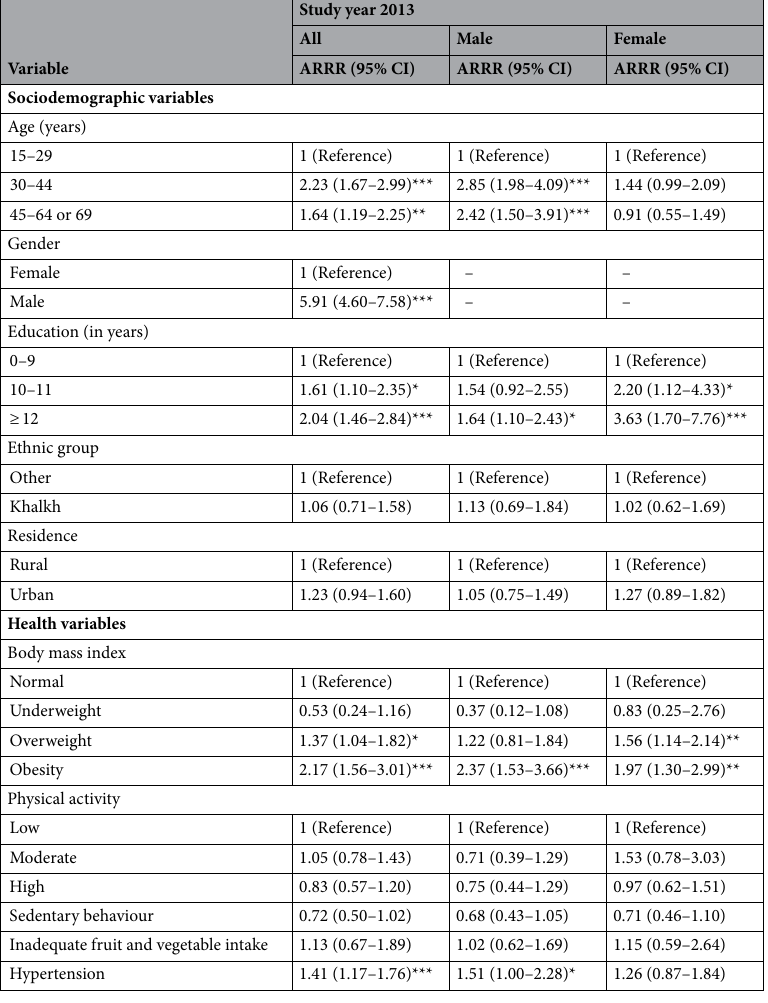
Table 13. Associations with current heavy drinking only (with non-current tobacco and non-current heavy drinking as reference category) among 15 years and older individuals in Mongolia, 2013. *** p <